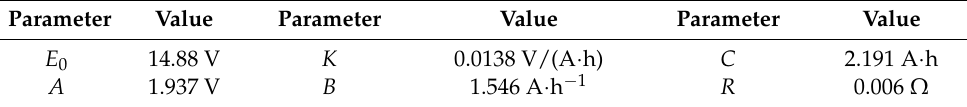
Figure 18. Fitting and simulation of the battery model: ( a ) comparison of test data with the fitting curve; ( b ) simulation of voltage profile for different discharge rates. Table 5. Parameters of the battery discharge model.